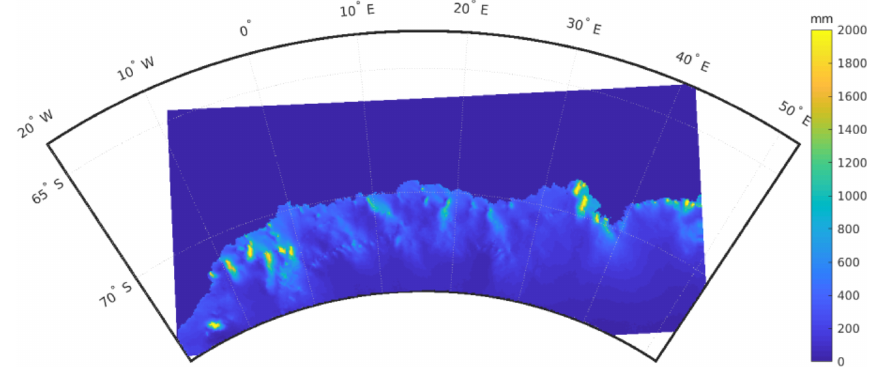
Figure 6. Map of downscaled snowfall accumulated over a year (CESM2 member 1). A saturation at 2000mm has been imposed for a better visualization.